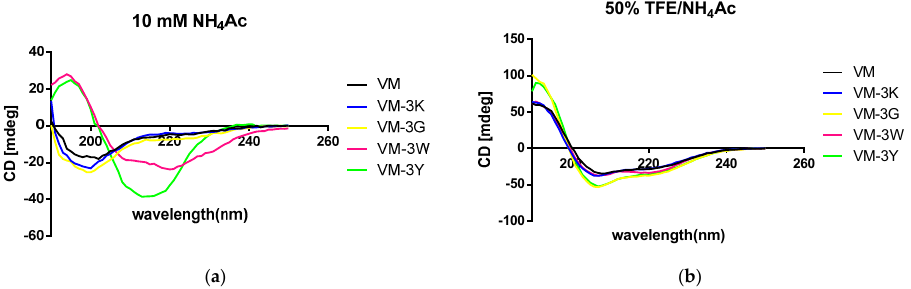
Figure 1. CD spectra recorded for all VM family peptides (100 µM) in ( a ) 10 mM NH 4 Ac; ( b ) 50% ( v/v ) trifluoroethanol (TFE)/10 mM NH 4 Ac. Each CD spectrum represents the average of three scans. Table 3. α -helical content of five VM peptides calculated by BeStSel [20].